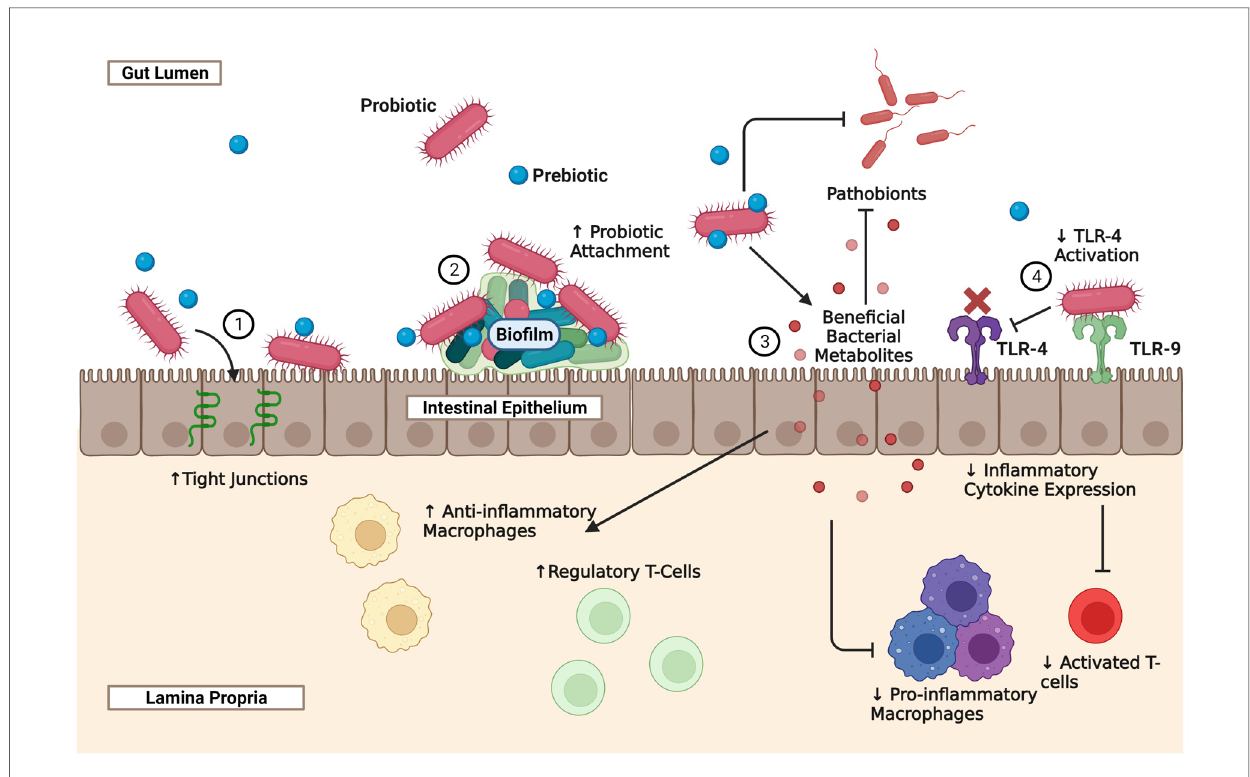
FIGURE 1 The effect of probiotics and prebiotics on the intestinal epithelium, immune system, and microbiome. Necrotizing Enterocolitis is a complex disease that is in part due to prematurity of the neonatal intestine, prematurity of the developing immune system, and dysbiosis. Probiotics, prebiotics, and synbiotics represent potential novel strategies for modulating all three of the intestine, the immune system, and the microbiome, in order to reduce the incidence and severity of NEC. The mechanisms through which probiotics provide bene fi ts vary depending on the species and strain administered, the adjunct use of prebiotics, the use of novel probiotic delivery systems, and dosing regimens. The schematic illustrates some of the major known effects of probiotics on the developing gut that are relevant to NEC: (1) probiotics can improve gut-barrier function by preserving tight junction proteins such as claudin 4 and occludin. Probiotics also have anti-apoptotic and cytoprotective effects on the neonatal intestine; (2) probiotics that are highly adhesive to the gut intestine produce complex bio fi lms that improve the attachment and theoretically the ef fi cacy of the probiotic; (3) through direct competition or the production of anti-microbial compounds, probiotics can reduce the presence of pathobionts that contribute to the dysbiosis seen in NEC. Probiotics can also metabolize environmental substrates such as tryptophan to produce bene fi cial bacterial metabolites that can reduce the presence of pro- in fl ammatory macrophages and activated T-cells, and increase the populations of anti-in fl ammatory macrophages and regulatory T-cells; (4) some probiotics are also able to indirectly inhibit the TLR-4 pathway, by interacting with TLR-9. TLR-4 is the receptor for LPS, a microbial cell wall product that is thought to play a role in the pathogenesis of NEC and is commonly used as a stressor in animal models of the disease. By inhibiting TLR-4 activity, there is a reduction in in fl ammatory cytokines and an increase in regulatory